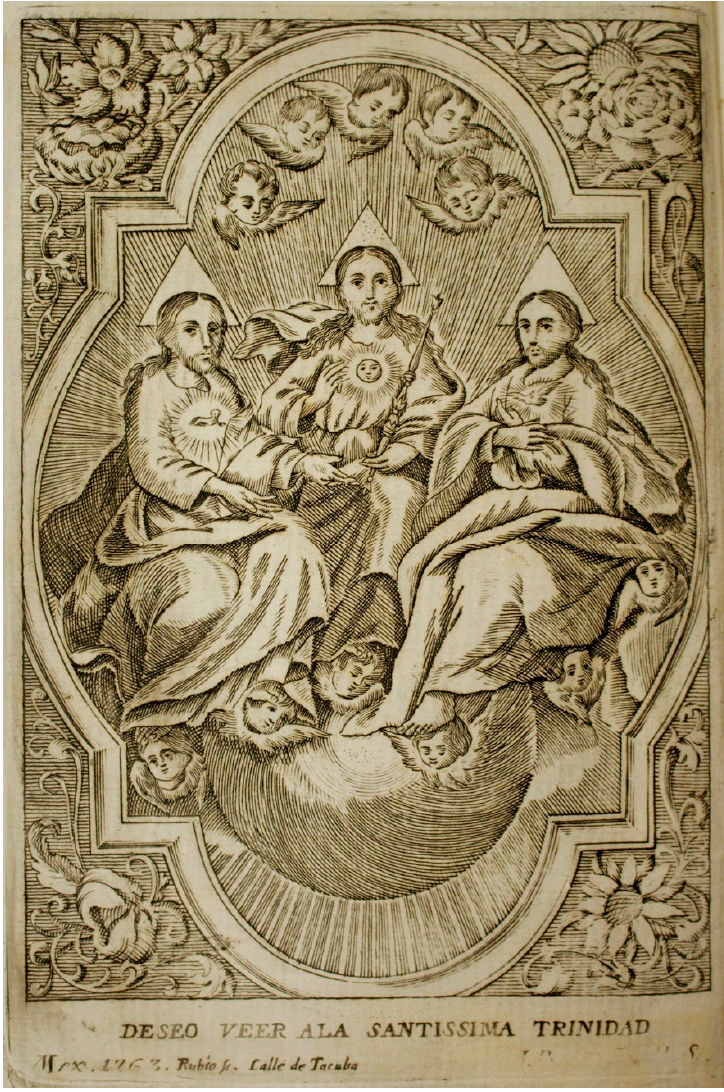
Figure 6. Augustín Rubio, Santísima Trinidad , ca. 1780. Engraving. Photograph used with permis- Figure 6. August í n Rubio, Sant í sima Trinidad , ca. 1780. Engraving. Photograph used with permission sion of the Santa Bárbara Mission Archive Library. of the Santa B á rbara Mission Archive